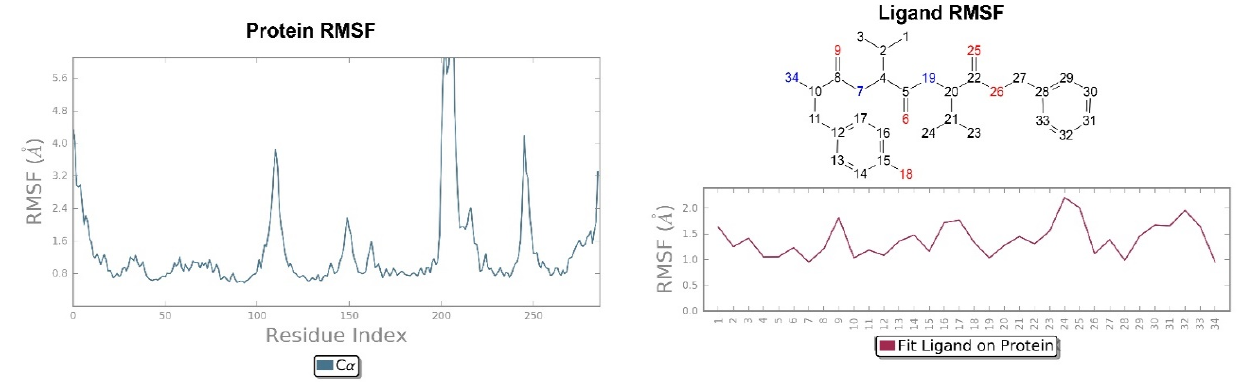
Figure 7. On the left: P-RMSF, receptor kappa; on the right: L-RMSF di H-D-Tyr-Val-Val-OBz.